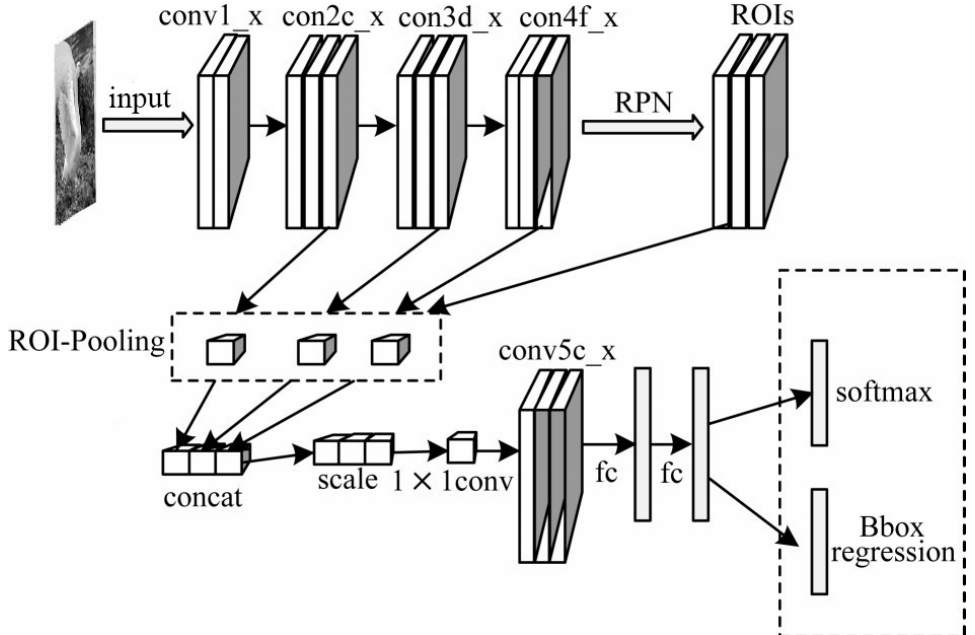
Figure 2. Structure of the whole work